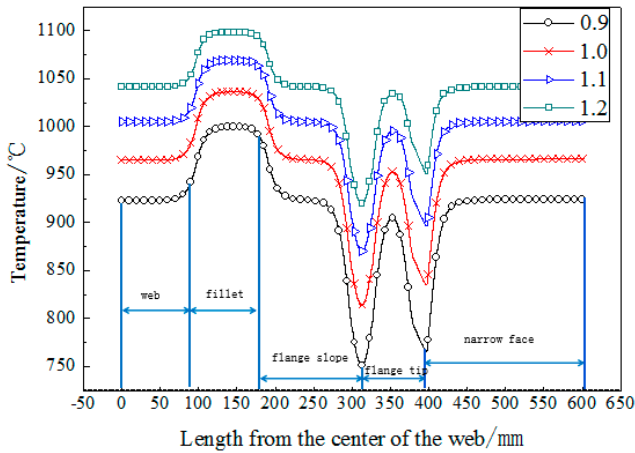
Figure 13. Temperature along the outer boundary at the exit of the mold at different casting speeds.